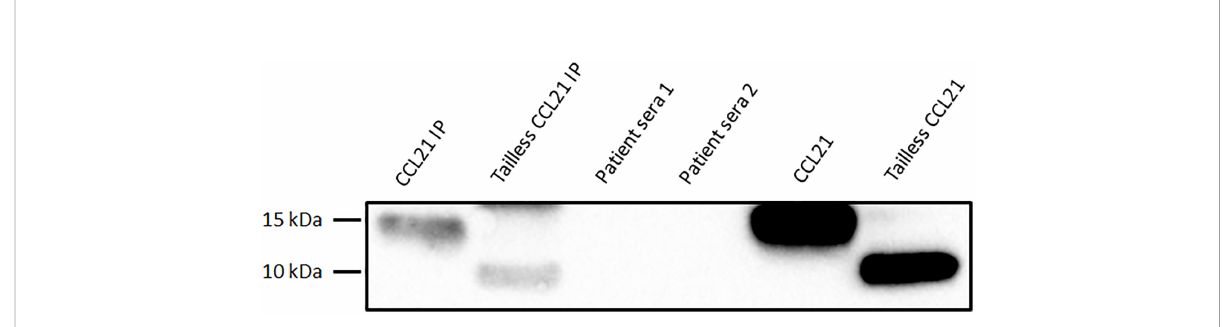
FIGURE 9 Western blot of SSc serum samples. The four fi rst lanes show the IP product of 1: costume made CCL21, 2: Tailless CCL21, 3: Patient serum 1, and 4: patient serum 2. The last two lanes CCL21 and Tailless CCL21 directly loaded on the gel.